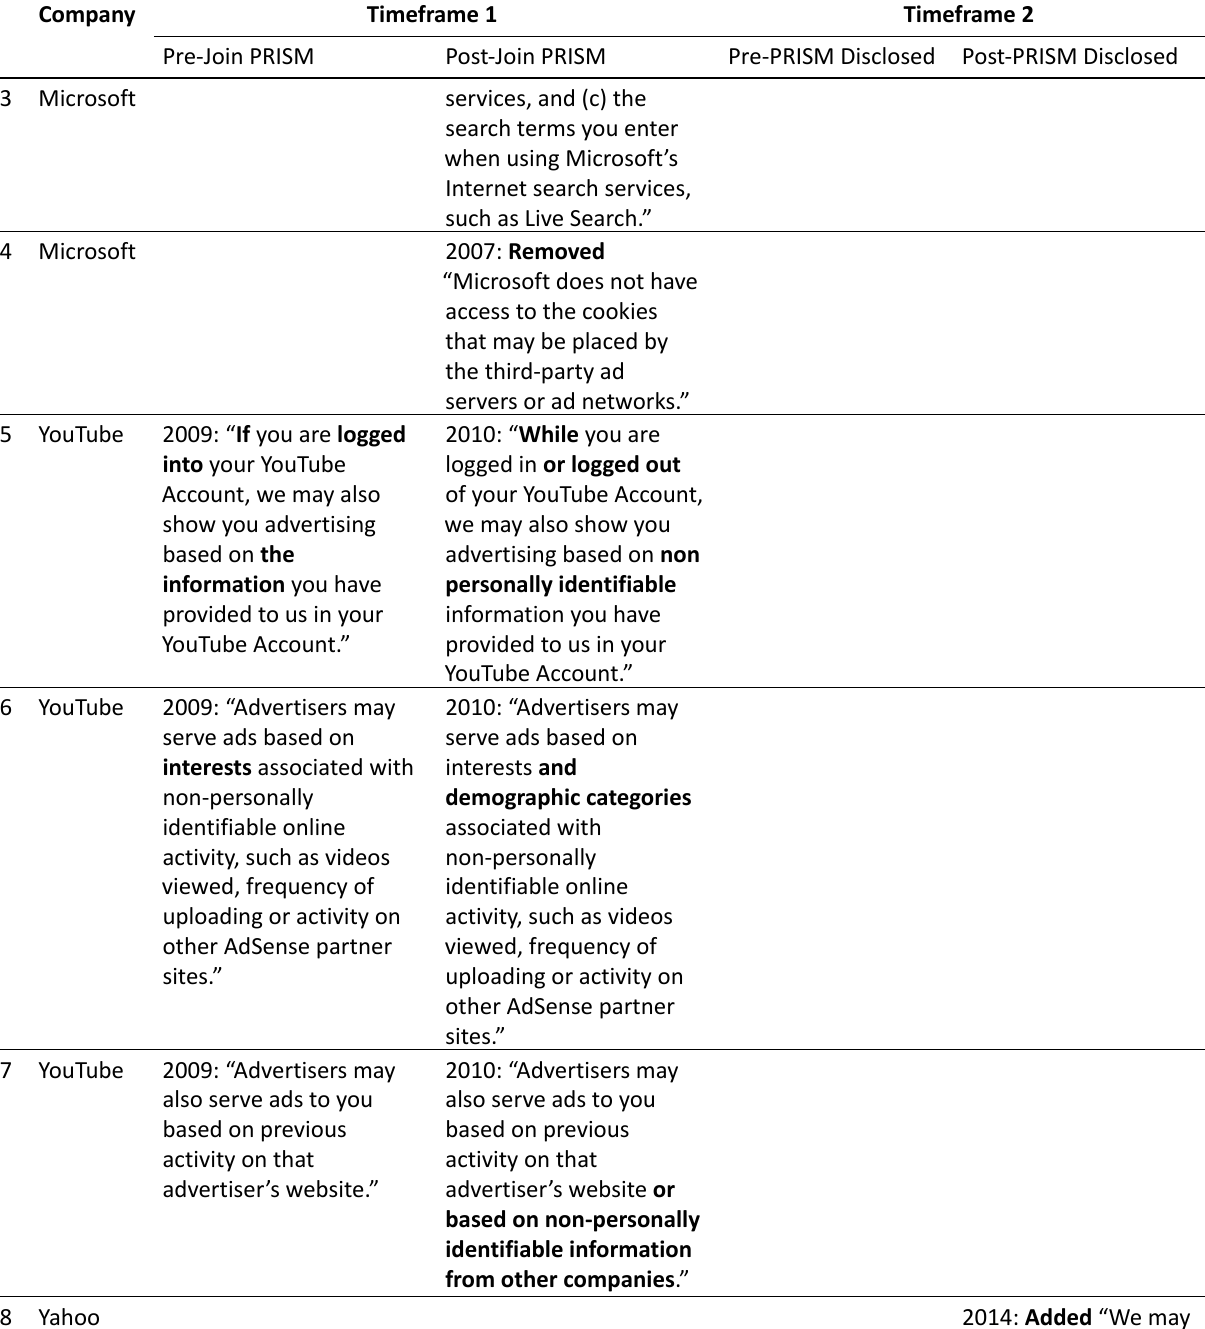
Table A.2. Privacy policy changes related to data sharing and tracking.